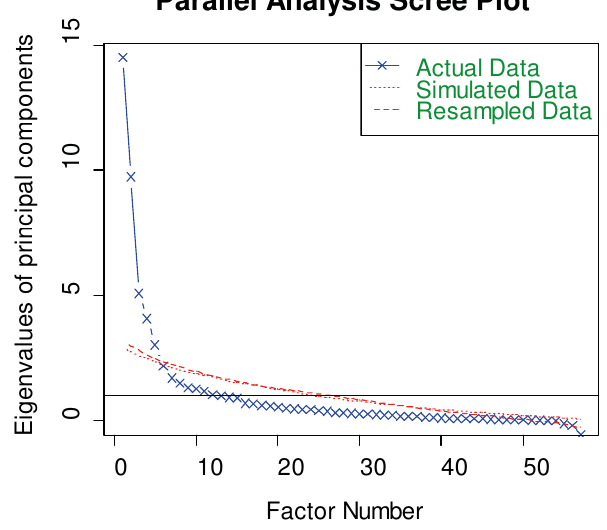
Fig. 3. Scree plot of PCA including results from parallel